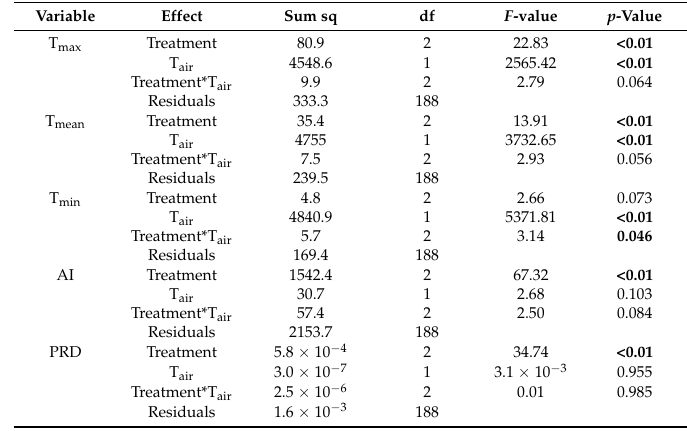
Table 1. Analysis of co-variance (ANCOVA, type II tests) of the response of maximal (T max ), mean (T mean ) and minimal (T min ) leaf surface temperatures, as well as aggregation index (AI) and patch richness density (PRD) to the different treatments (presence of aphids, vegetable oil or intact leaves) with air temperature as a covariable. The replicate (leaf identity) was set as a random factor. p -Values below the threshold of 0.05 are indicated in bold. Legend: T air , air temperature; Sum sq, sum of squares; df, freedom